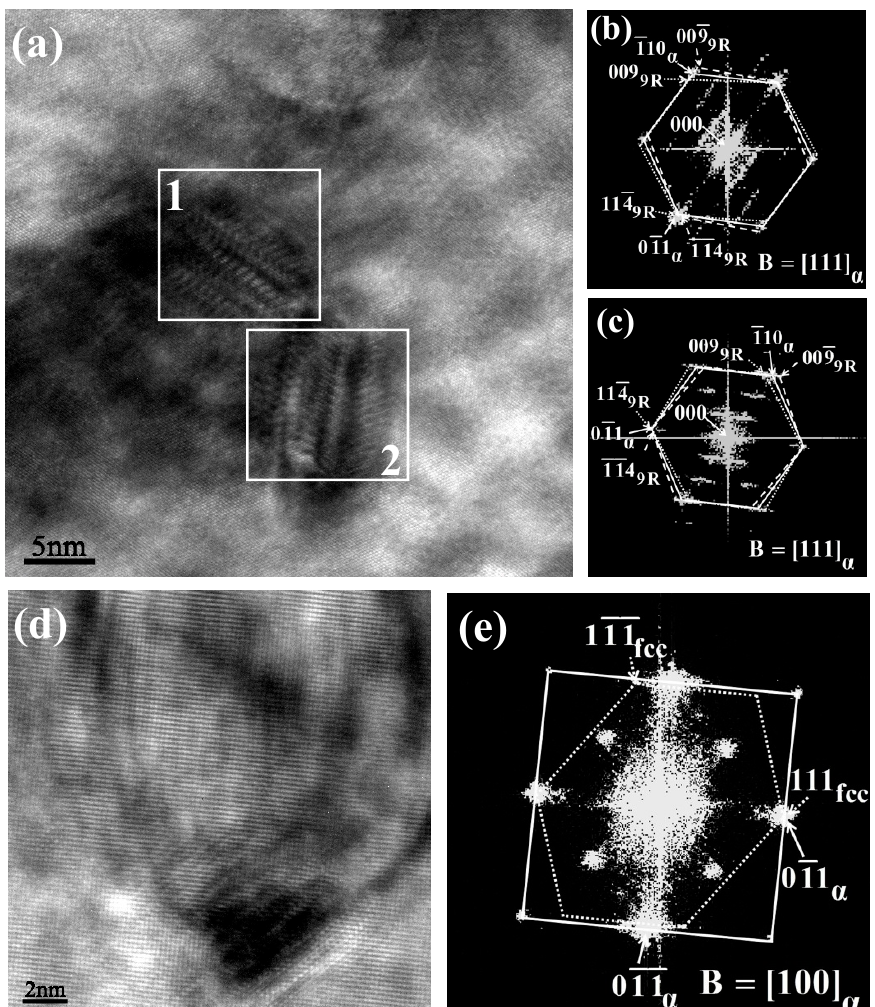
Figure 4. HRTEM images and their fast Fourier transform (FFT) patterns of Cu precipitates: ( a ) twinned 9R Cu image after aging for 1 h; ( b ) the FFT pattern of the square region 1 marked in ( a ); ( c ) the FFT pattern of the square region 2 marked in ( a ); ( d ) stable fcc Cu image after aging for 3 h; and ( e ) the FFT pattern of ( d ).